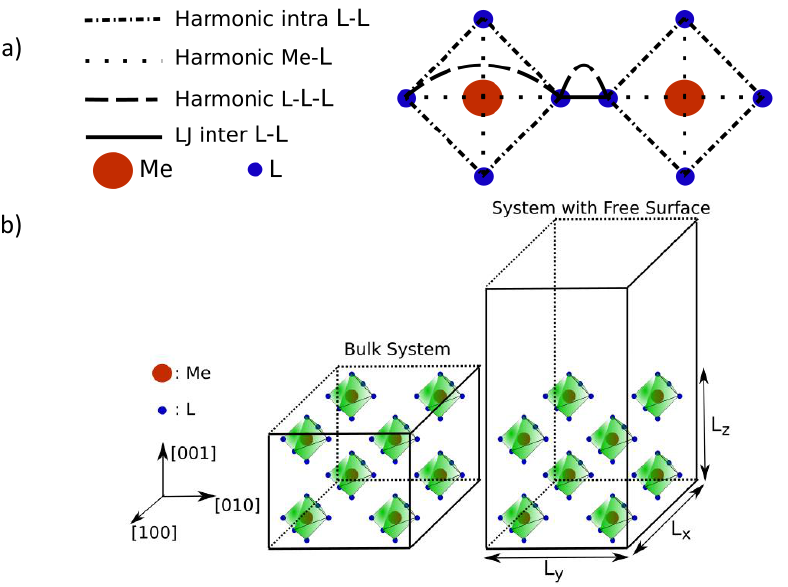
Figure 1. ( a ) Schematic representation of the different harmonic and anharmonic bonds included in the force field. Within an octahedron: harmonic pairwise potentials to model the metal-ligand (Me-L) interactions (dotted straight line) and the intra-octahedron ligand-ligand (LL-intra) bonds (dashed-dotted straight line). Between octahedra: the harmonic angular potential between three consecutive ligands is represented by dashed curved lines. The inter-octahedra anharmonic Lennard Jones (LJ) pairwise potential is symbolized by a solid line. ( b ) 3D schematic representations of the different boundary conditions employed for molecular dynamics simulations. Left: a model system with periodic boundary conditions in the three space directions employed for the slab-adapted method to simulate bulk materials. Right: The increase of the simulation box produced a “vacuum” between the two facing surfaces normal to the z direction, modeling a system with two free (100) surfaces for the slab method . Table 1. Summary of the numerical parameters used in the molecular dynamics